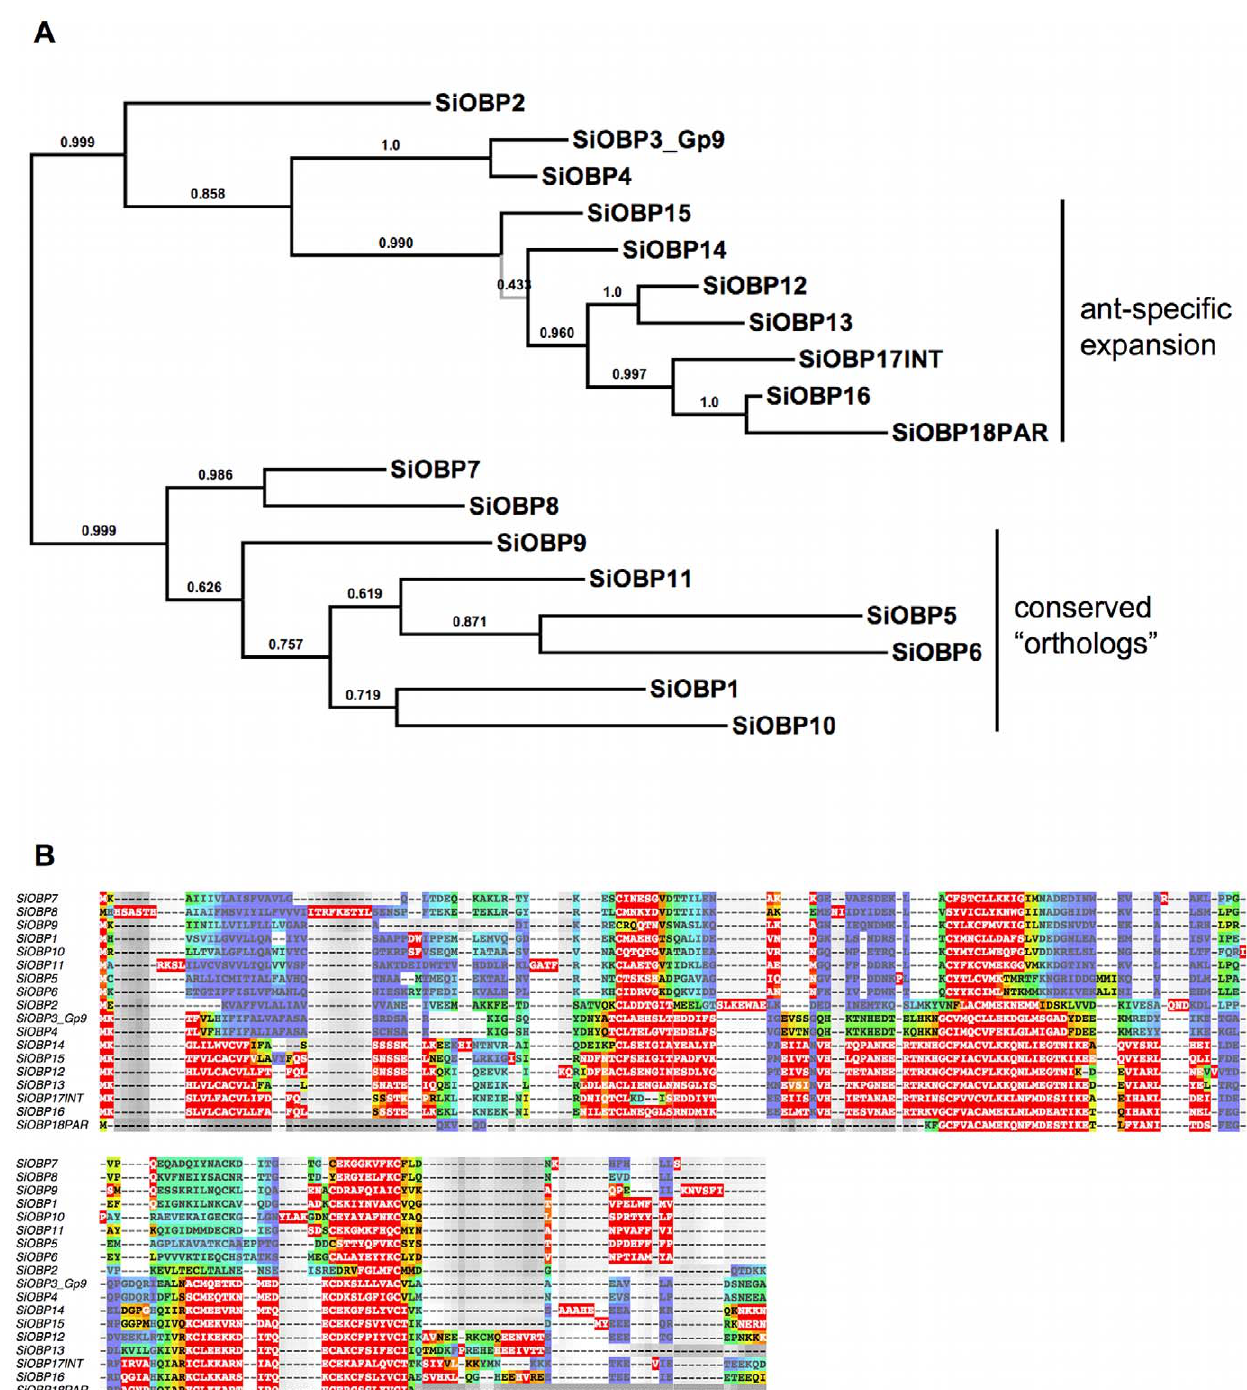
Figure 1. Maximum a-posteriori (MAP) phylogeny and alignment of the Solenopsisinvicta (SiOBP) odorant binding proteins. A. The S. invicta MAP phylogeny. The branch in grey is collapsed in the 50% consensus tree. Branch support is posterior probabilities derived from 3241 samples taken after the burn-in was discarded. Even though the node support in the conserved ortholog clade is relatively poor, the exact same topology of the orthologs was recovered in the honey bee MAP tree (not shown), suggesting that the branching pattern is accurate. B. The S. invicta MAP-AU plot. The quality of the alignment is indicated through a heat map. Red (warm colors) indicates areas of high quality alignment, blue (cold colors) signifies areas of low certainty. Note that there are considerable high quality alignment blocks in the N-terminal signal peptide and the C-terminal protein tail.